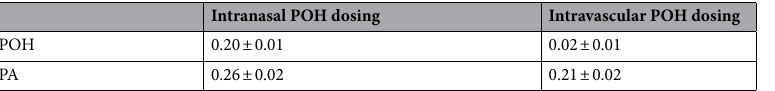
Table 3. CSF/plasma ratios. CSF/plasma ratios for perillyl alcohol (POH) and perillic acid (PA) following intranasal and intravascular POH administration. Values are depicted as mean ± standard error of mean (SEM).